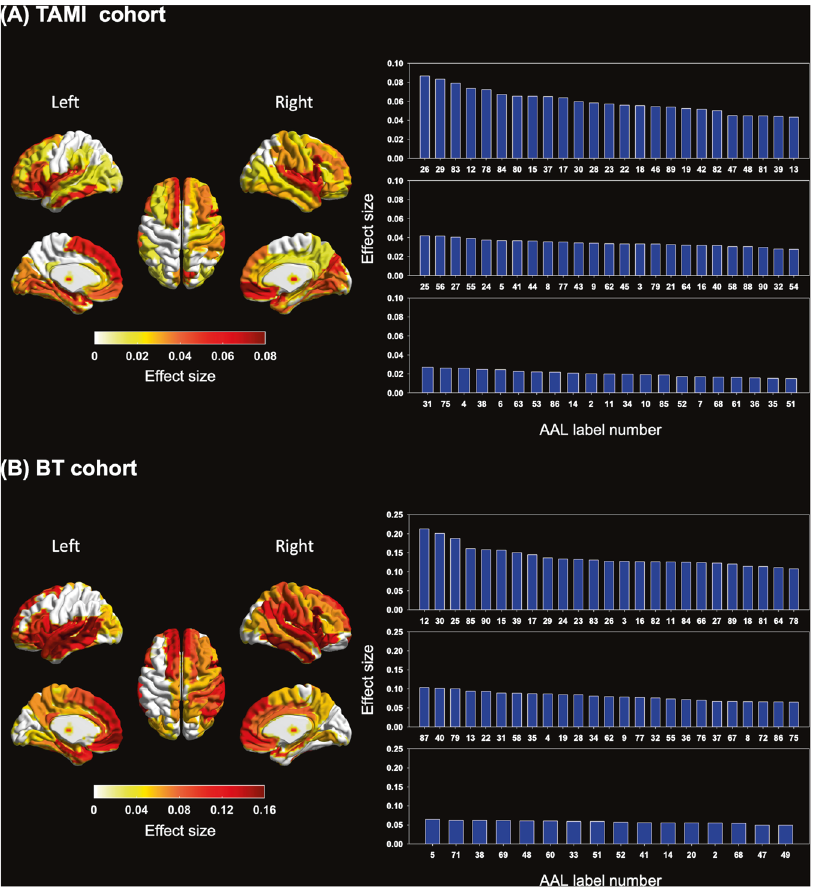
Fig. 2 Group differences in brain age gaps between participants with schizophrenia and HCs in 90 models for GM map in the two cohorts. A Subplot A illustrates the brain regions with signi fi cantly accelerated aging and the effect sizes in participants with schizophrenia in the TAMI cohort. B Subplot B presents the brain regions with signi fi cantly accelerated aging and effect sizes in participants with schizophrenia in the BT cohort. The brain regions in the left panel display signi fi cant differences in brain age gaps after FDR correction in the TAMI and BT cohorts. The color bar represents effect size (partial η 2 ). The right panel presents bar charts of effect sizes (partial η 2 values) for brain regions with signi fi cant differences. The brain regions corresponding to the AAL number are presented in Supplementary Table 4. Participants with schizophrenia had signi fi cant brain aging trajectory deviations in 71 of the 90 models for GM map in the TAMI cohort. Moreover, 66 brain regions had signi fi cantly larger brain age gaps in participants with schizophrenia than in HCs in the BT cohort. We found 10 brain regions with the most pronounced deterioration in both cohorts, occurring primarily in the frontal lobe, temporal lobe, and insula (see Supplementary Table 4). TAMI Taiwan Aging and Mental Illness, BT Tri-Service General Hospital Beitou Branch, FDR false discovery rate, AAL automated anatomical T = 3.20, adjusted P = 0.005), left cerebral peduncle (beta = 0.26, T = 3.92, adjusted P = 0.001), bilateral posterior corona radiata (left: beta = 0.17, T = 3.30, adjusted P = 0.007; right: beta = 0.17, T = 3.59, adjusted P = 0.003), left sagittal stratum (beta = 0.18, T = 3.80, adjusted P = 0.002), bilateral fornix cres/stria terminalis (left: beta = 0.22, T = 4.41, adjusted P < 0.001; right: beta = 0.18, T = 3.23, adjusted P = 0.005), and right tapetum (beta = 0.14, T = 3.25, adjusted P = 0.006) (Fig. 4). For the result of age of onset, we found that the age of onset of individuals with schizophrenia had a negative association with the brain age gaps in four white matter tracts, including middle cerebellar peduncle (beta = − 0.18, T = − 3.41, adjusted P = 0.01), splenium of corpus callosum (beta = − 0.18, T = − 2.88, adjusted P = 0.05), right cerebral peduncle (beta = − 0.18, T = − 2.76, adjusted P = 0.05), and left cerebral peduncle (beta = − 0.21,